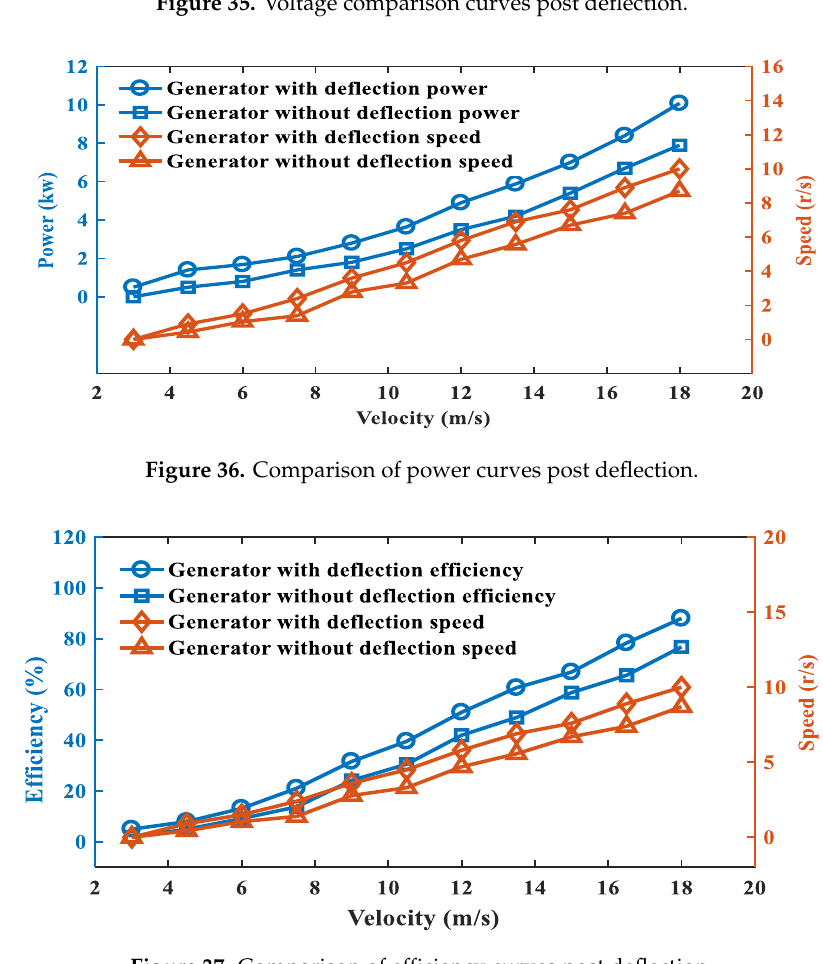
Figure 37. Comparison of efficiency curves post deflection.